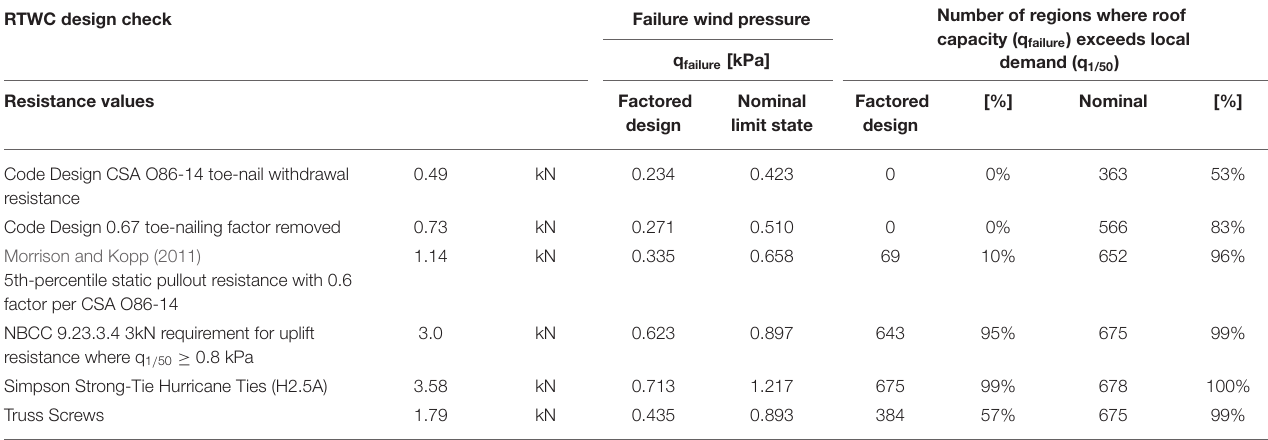
TABLE 4 | Design check for RTWCs showing factored and unfactored design wind pressures, adjusted for suburban terrain, as well as a comparison to the design wind pressures in NBCC (Canadian Commission on Building and Fire Codes, 2015) climate zones. RTWC design